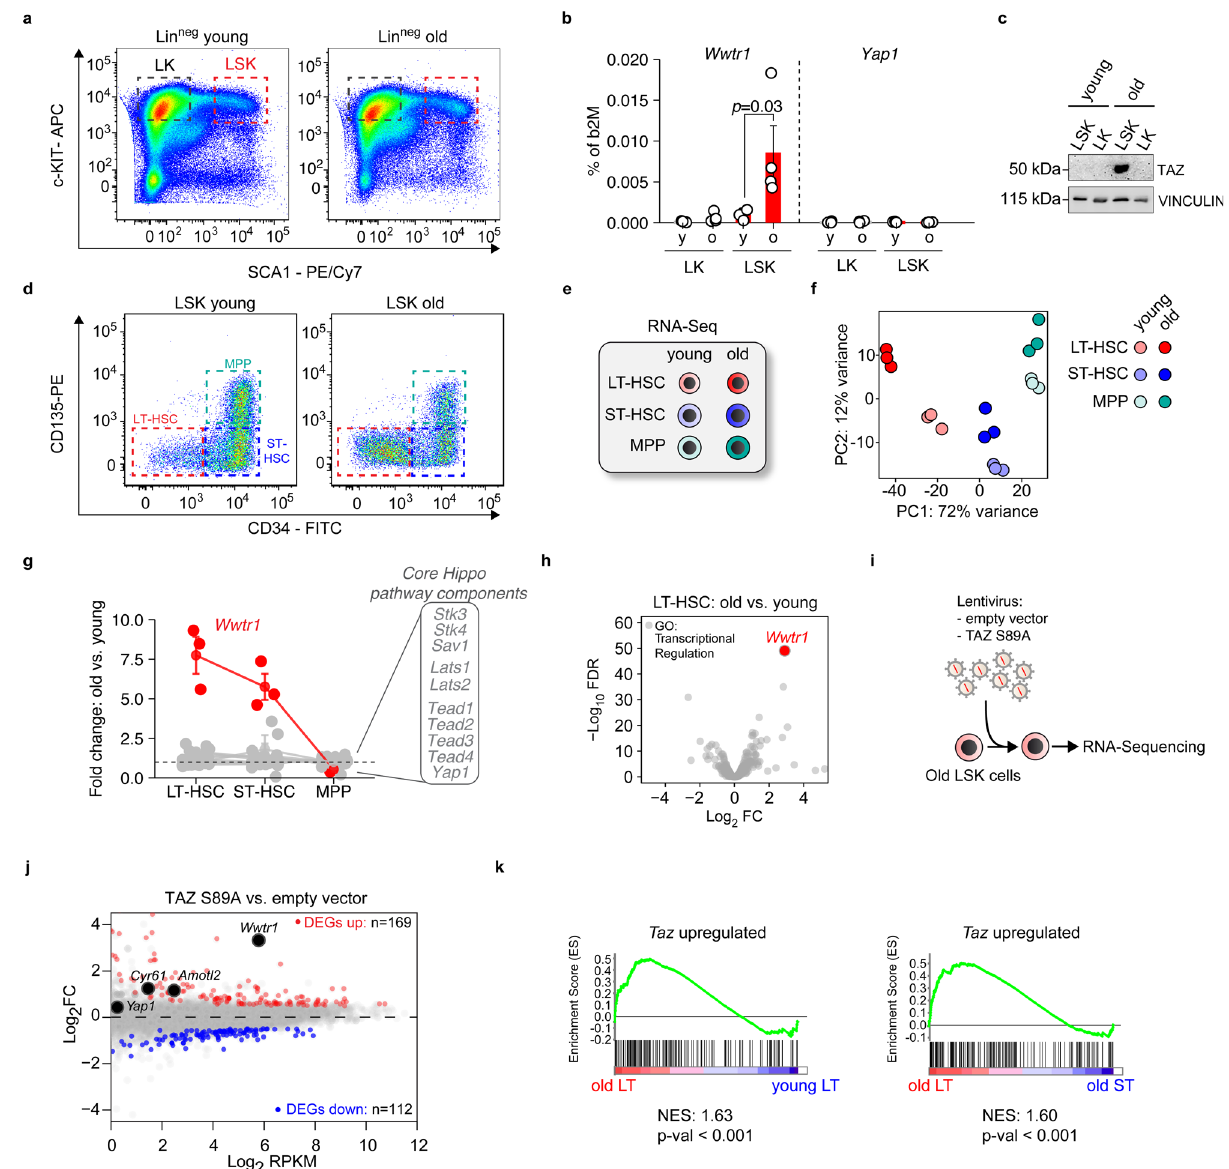
Fig. 1 | TAZ ( Wwtr1 ) is strongly induced in oLT-HSCs. a Representative fl ow cytometry plots of LK (Lineage neg , Sca-1 neg , c-Kit pos ) and LSK (Lineage neg , Sca-1 pos , young and old mice. d Representative fl ow cytometry plots of LT-HSCs, ST-HSCs, andMPPintheLSKcompartmentofyoungandoldmice. e Overviewofthesamples thatwereanalyzedbyRNA-Seq( n =3pergroup). f Principalcomponentanalysisof the RNA-Seq of the indicated populations ( n =3 per group). g Summary of gene expressionchanges(oldvs.young)ofHippopathwaycorecomponents. h Volcano